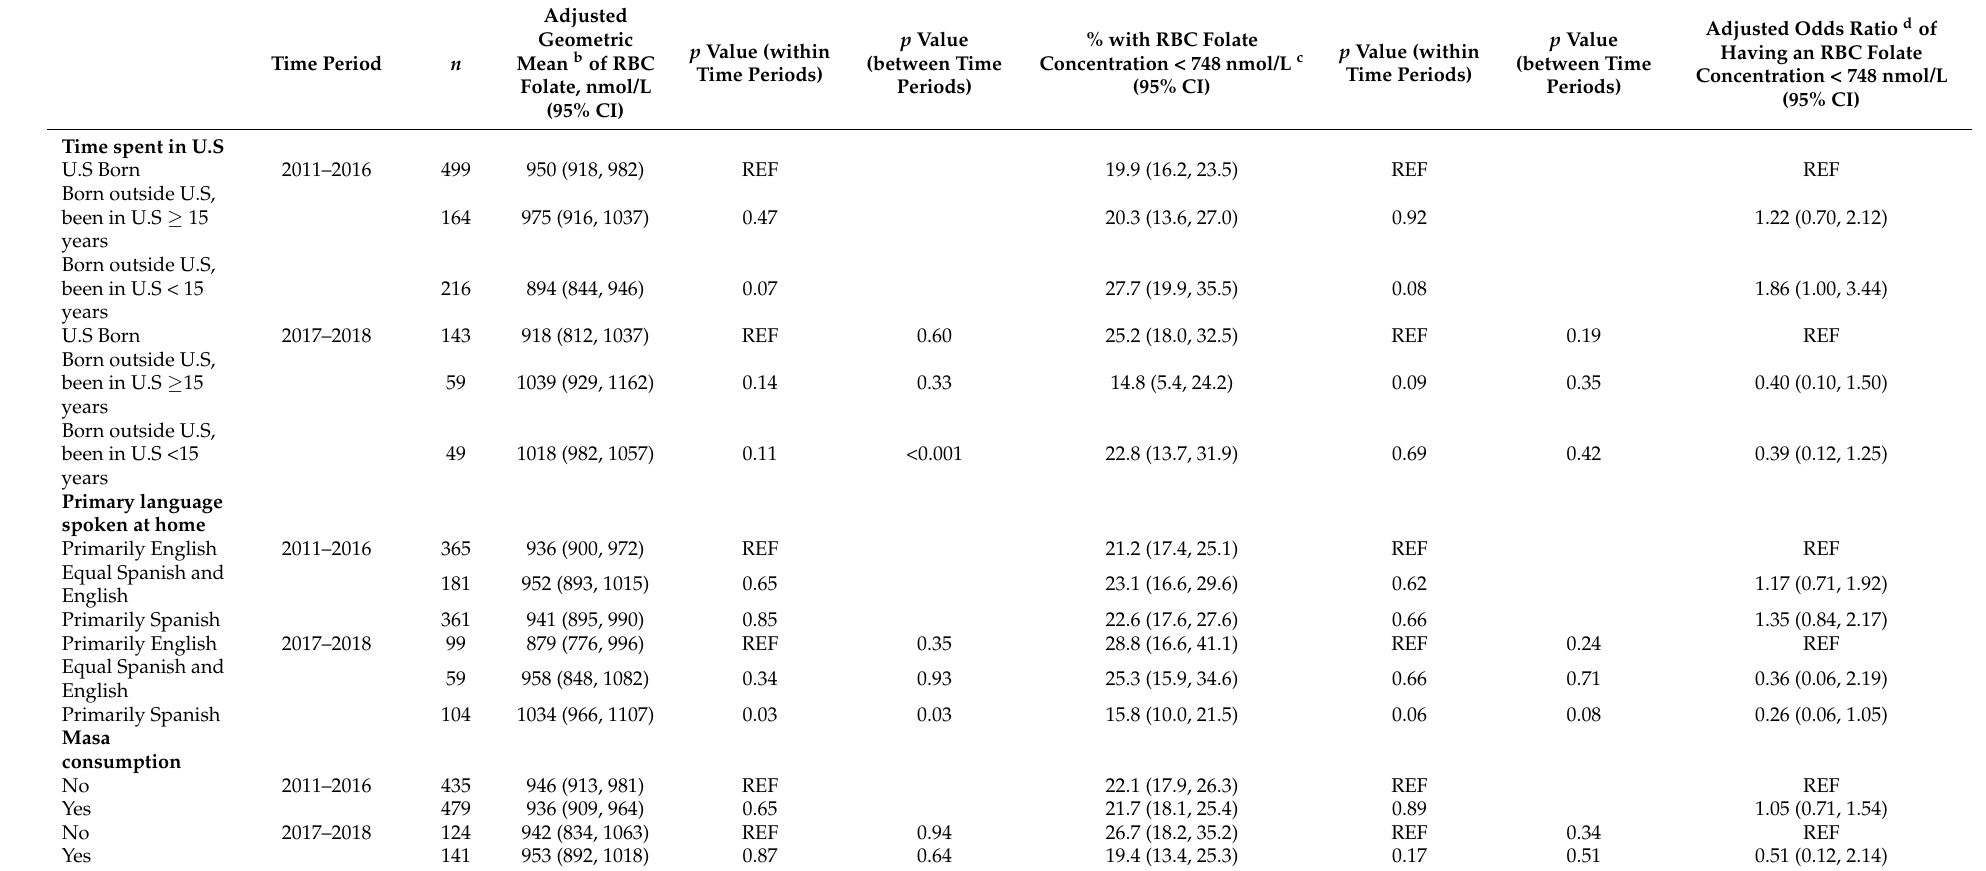
a Abbreviations: enriched cereal grain product (ECGP), National Health and Nutrition Examination Survey (NHANES), red blood cell (RBC); b Geometric means adjusted for age, education, poverty-income ratio (PIR), body mass index (BMI), and ethnicity; c Associated with NTD rate of ≥ 9 per 10,000 live births; d Odds ratios adjusted for age, education, PIR, BMI, and ethnicity; p -values determined using Student’s t -test. “Between time periods” examined differences pre- and post-fortification within the subpopulation; “Within time periods” examined differences between the subpopulation and reference group within the pre- or post-fortification time